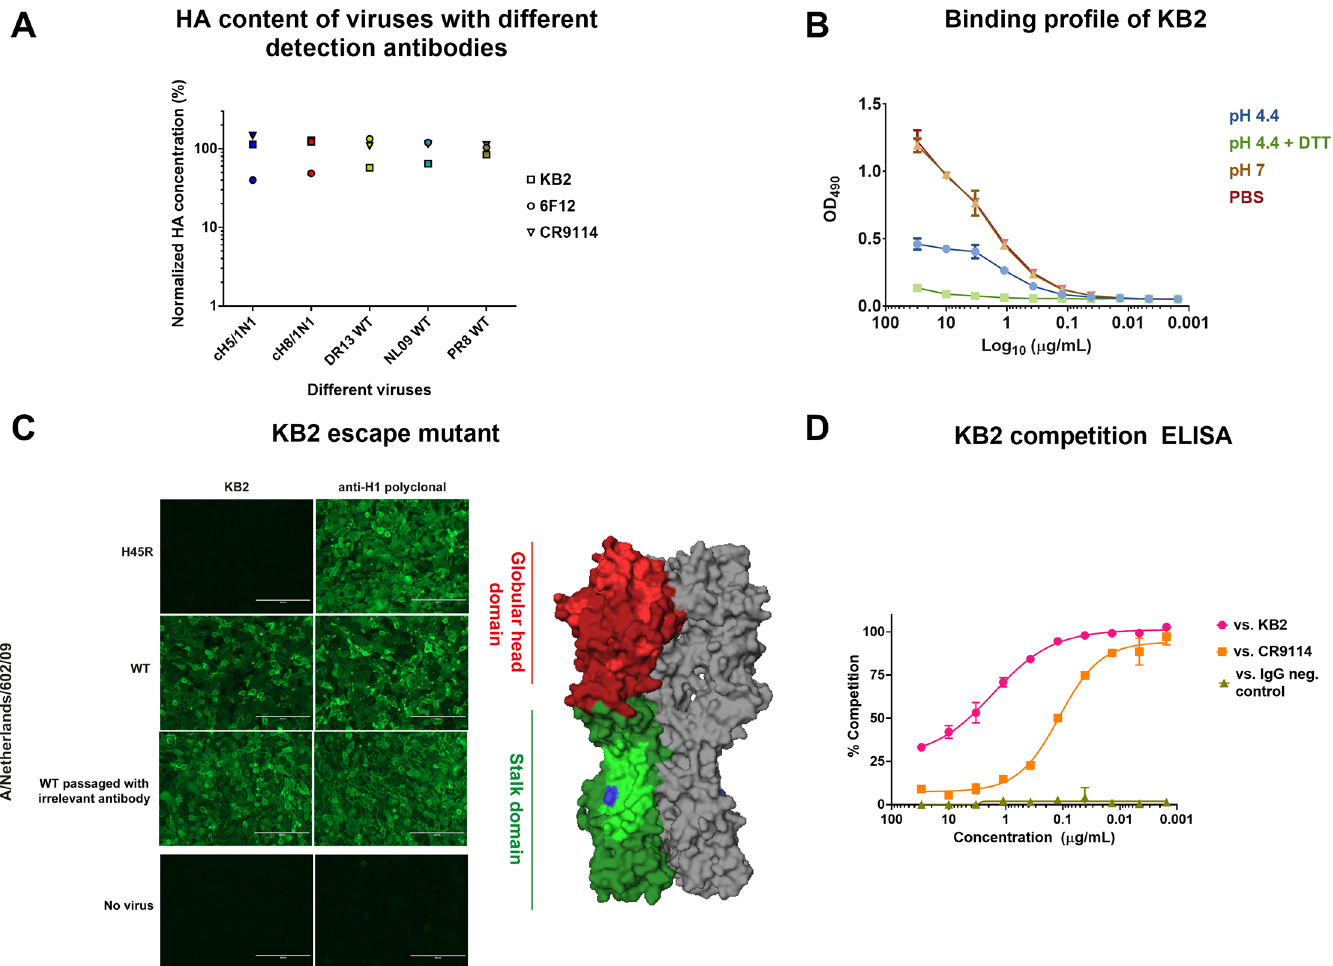
Fig 2. Selection and characterization of the detection mAb. (A) Capture ELISAs were performed using three different detection mAbs including murine stalk mAbs KB2 (binds to H1, H5 and H6), 6F12 (pan-H1 binder), and human mAb CR9114 (pan-HA binder). The detection capability of these antibodies was measured using five different purified virus preparations: cH8/1 Cal09 N1, cH5/1 Cal09 N1, DR13 (pandemic H1N1), NL09 (pandemic H1N1) and PR8 (H1N1). The amount measure with each mAb was normalized to the mean value of all three mAbs and expressed as percent of the mean. KB2 was selected for further assay development and characterized in more detail. ( B ) To understand if KB2 is sensitive to conformational changes of the HA a cH5/1 Cal09ss N1 purified virus preparation was coated on ELISA plates and exposed to either PBS control, buffered solutions at pH4.4 (with and without reducing agent DTT) or at pH7 for one hour, and finally brought back to neutral pH prior to performing the ELISA. (C) Immunofluorescent staining of NL09 wildtype (WT) virus and escape mutant infected MDCK cells was done using KB2 and polyclonal serum against H1. NL09 was also passaged in the presence of irrelevant mAb as control. The right panel shows the structure of HA. Red denotes the globular head domain, while green denotes the stalk domain. Head antigenic sites are denoted in light red, and the highly conserved stalk epitopes are denoted in light green (FI6v3, F10, CR9114, CR6261) [23, 35, 36, 47]. The H45R position in the stalk of the KB2 escape mutant is denoted in blue (PDB 1RU7 [30]). (D) Competition ELISA indicates that KB2 and CR9114 compete for the same epitope in the stalk domain of the H1 HA.